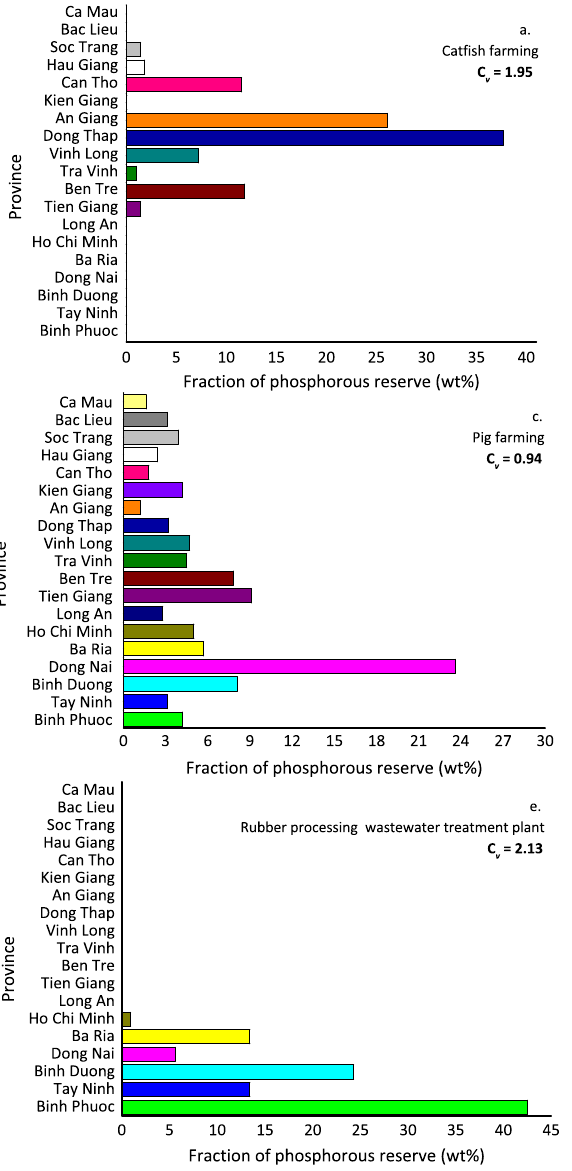
Fig. 4 P-reserve distribution in wt% by